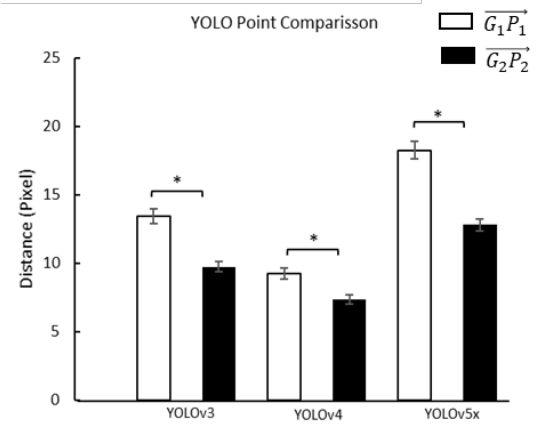
Figure 8. Comparisons of the effect of different YOLO models on the distances between the ground- truth point and prediction point at the front point of the angle-box ( 𝑮 𝟏 𝑷 𝟏 ⃗⃗⃗⃗⃗⃗⃗⃗⃗⃗ ), and rear points of the angle-box ( 𝑮 𝟐 𝑷 𝟐 ⃗⃗⃗⃗⃗⃗⃗⃗⃗⃗ ). *, a significant difference ( p < 0.01).